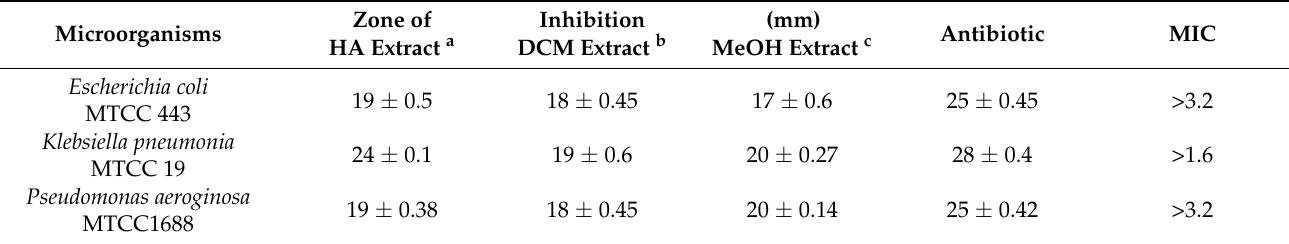
Table 2. Antibacterial activity of various extracts of N. mexicana Zucc